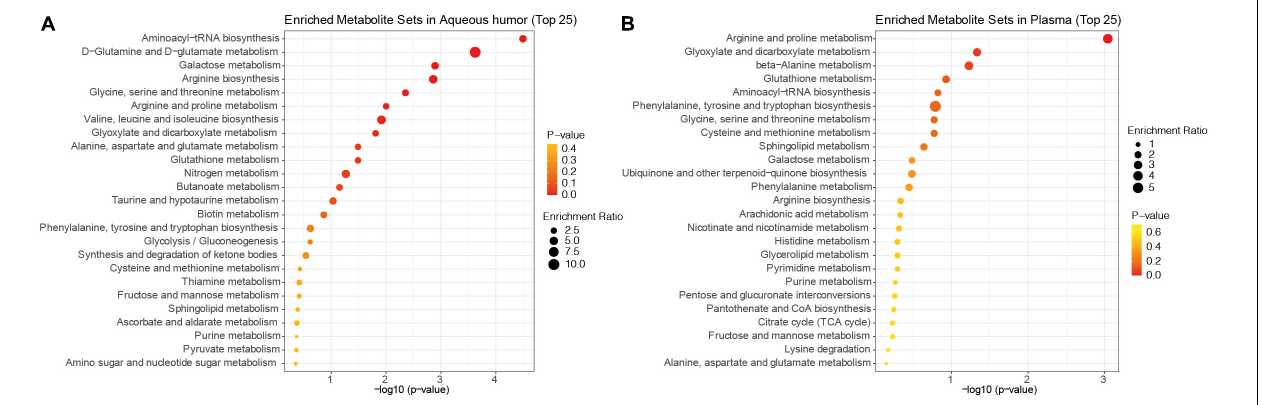
FIGURE 2 | KEGG pathway enrichment analysis of the pooled metabolites. Dot plots of differentially expressed metabolites in the aqueous humor (A) and plasma (B) of patients with POAG and controls ranked by p -value. The bubble size indicates the enriched factor in each pathway and the color bar shows the p -value.